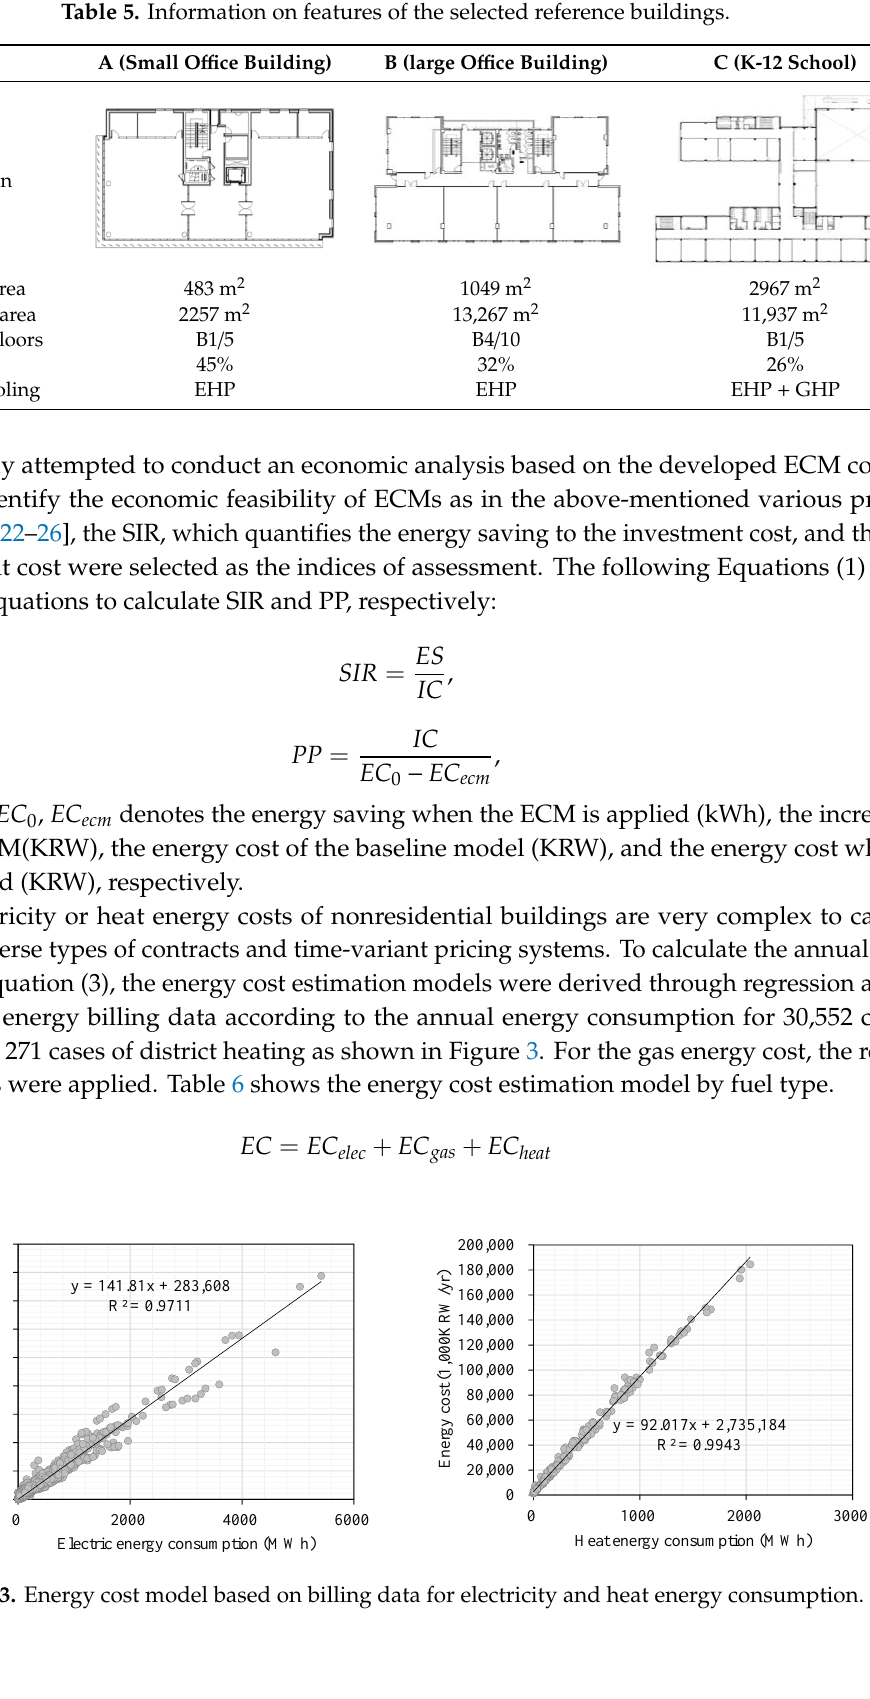
Table 4. The size distribution by building type and the selected representative values.